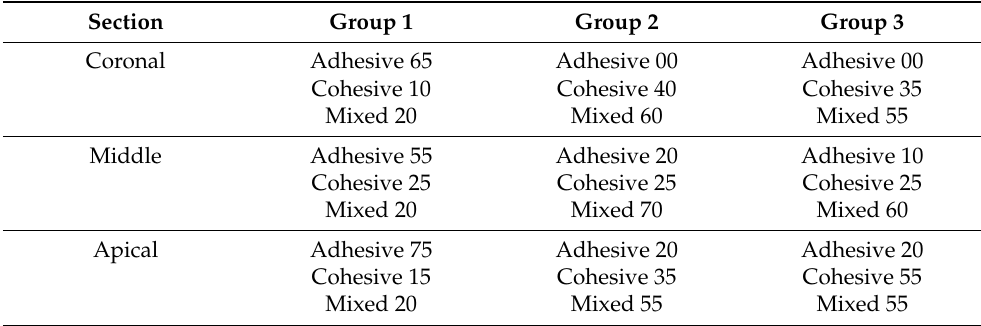
Table 3. The modes of failure for the three groups (Group 1: sodium hypochlorite and saline; Group 2: Arnica montana ; and Group 3: